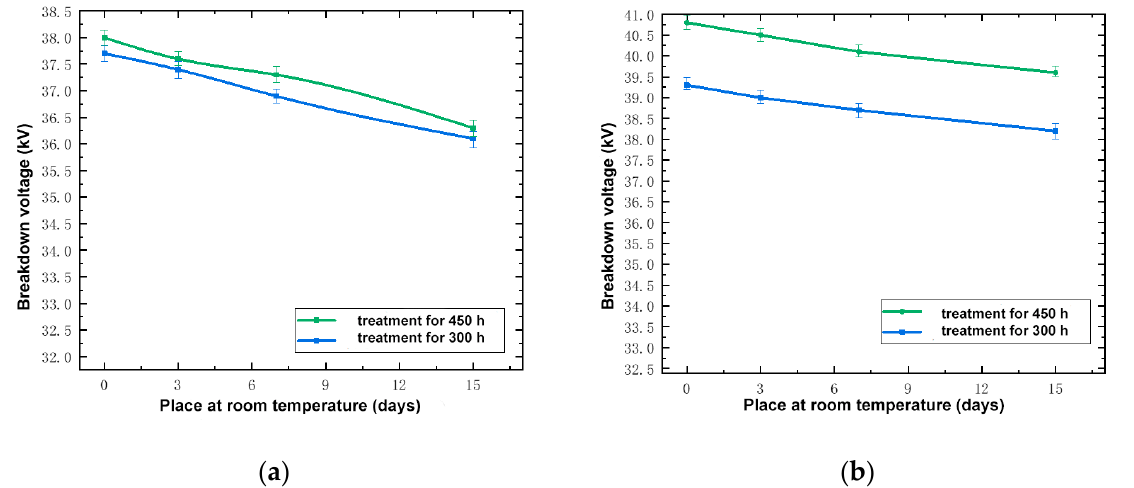
Figure 3. Relationship between breakdown voltage and days at room temperature. ( a ) Silicone rubber; ( b ) Fluorosilicone